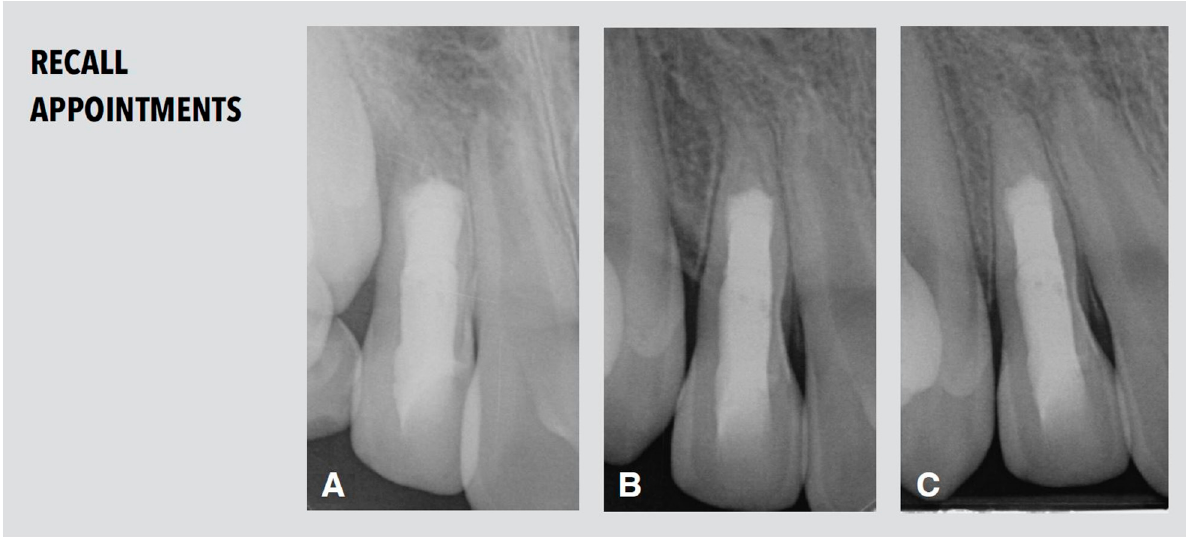
Figure 5. Radiological follow-up. ( A ) Periapical radiograph after nine months demonstrating increase in both root length and thickness in the apical part below the MTA level. ( B , C ) Periapical radiographs after two years ( B ) and after three years and nine month ( C ) demonstrating further root maturation.